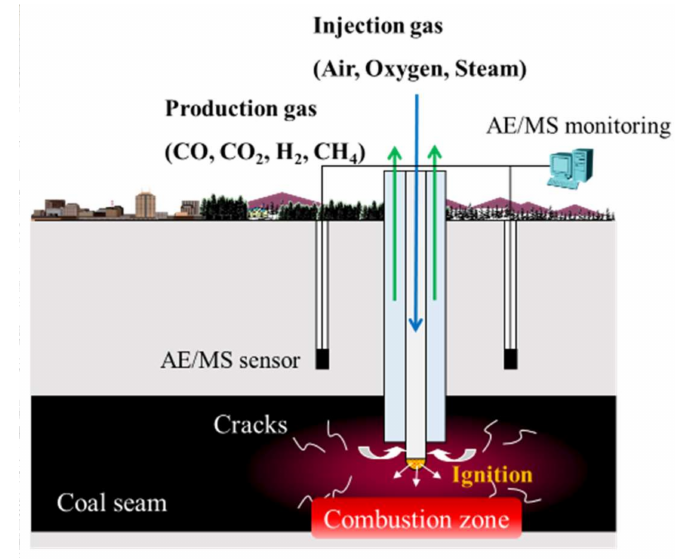
Figure 2. Coaxial UCG process with monitoring